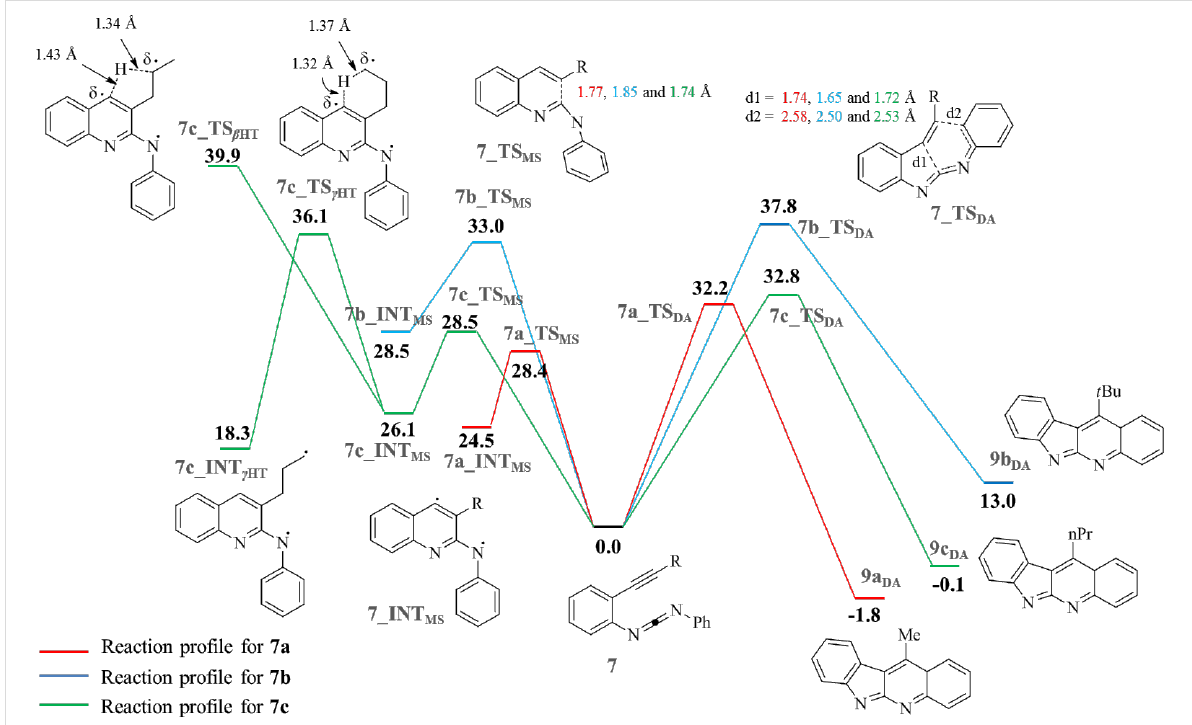
Figure 1: Reaction profile of 7a–c at BLYP/6-31+G* level. All bold numbers represent the respective free energies in kcal mol – 1 at 138 °C. Subscripts “ DA ”, “ MS ” and “ HT ” stand for “Diels–Alder”, “Myers–Saito” and “Hydrogen Transfer”,